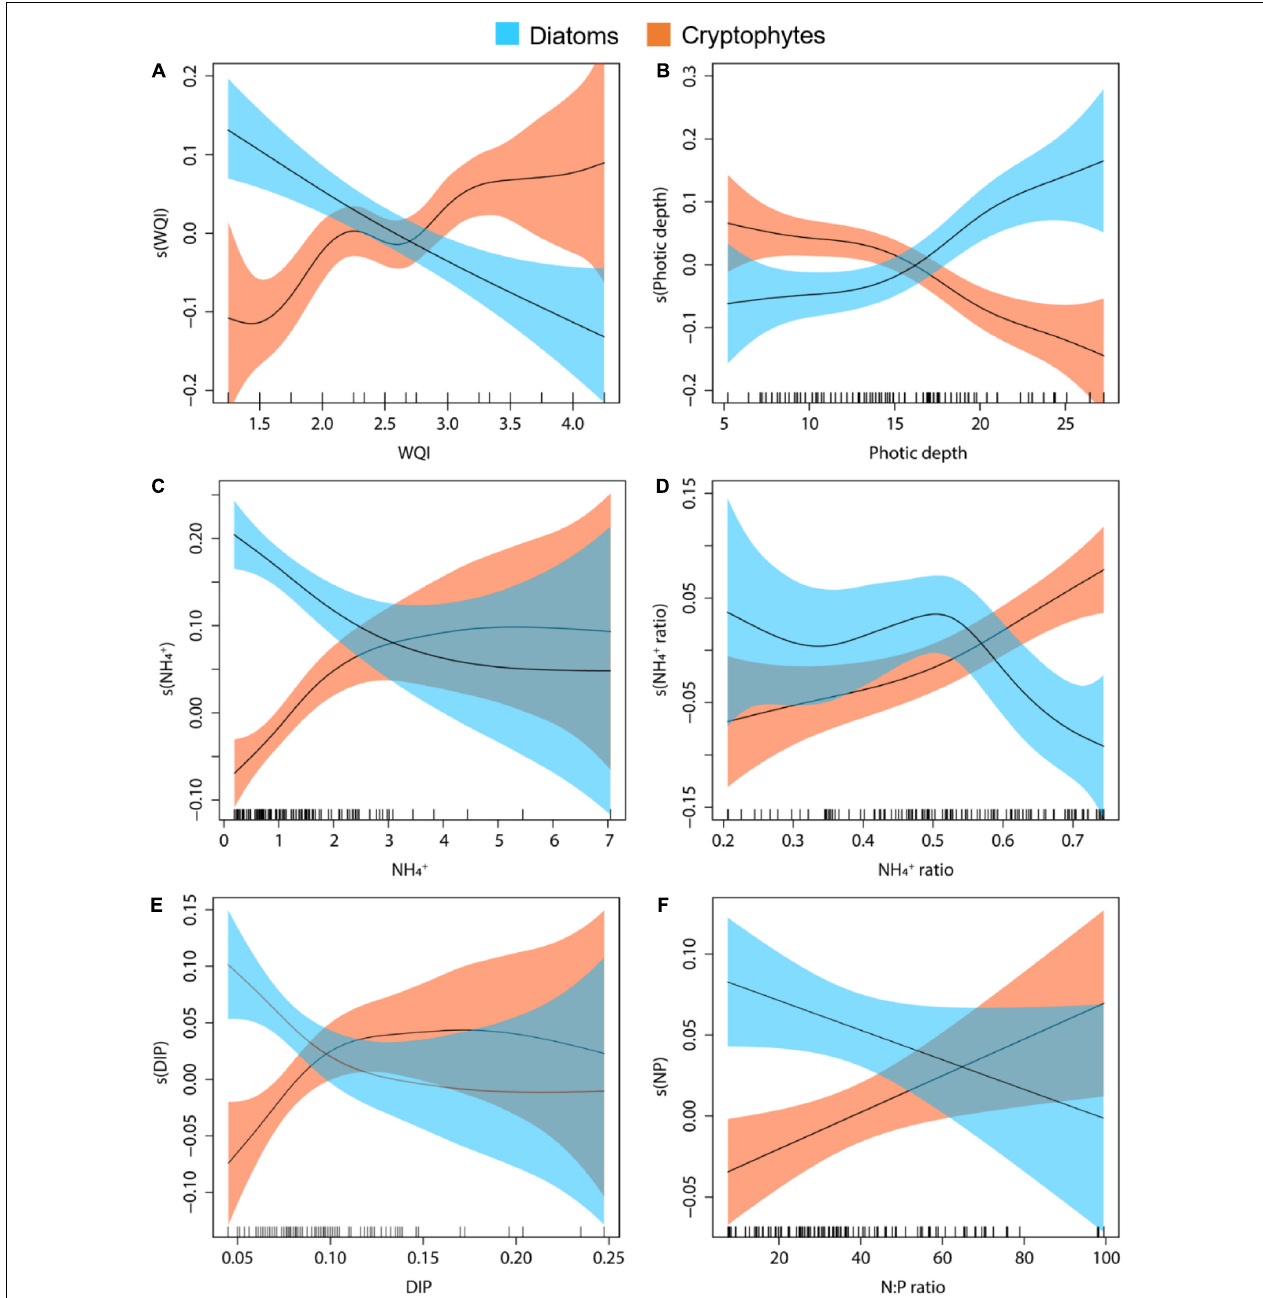
FIGURE 7 | Generalized additive models illustrating variations in the dominance of cryptophytes and diatoms in response to multiple parameters. Responses of cryptophytes and diatoms to the water quality index (WQI) (A) , responses to photic depth (B) , responses to NH 4 + (C) , responses to the proportion of NH 4 + in dissolved inorganic nitrogen (D) , responses to dissolved inorganic phosphate (DIP) (E) , and responses to the N:P ratio (F)